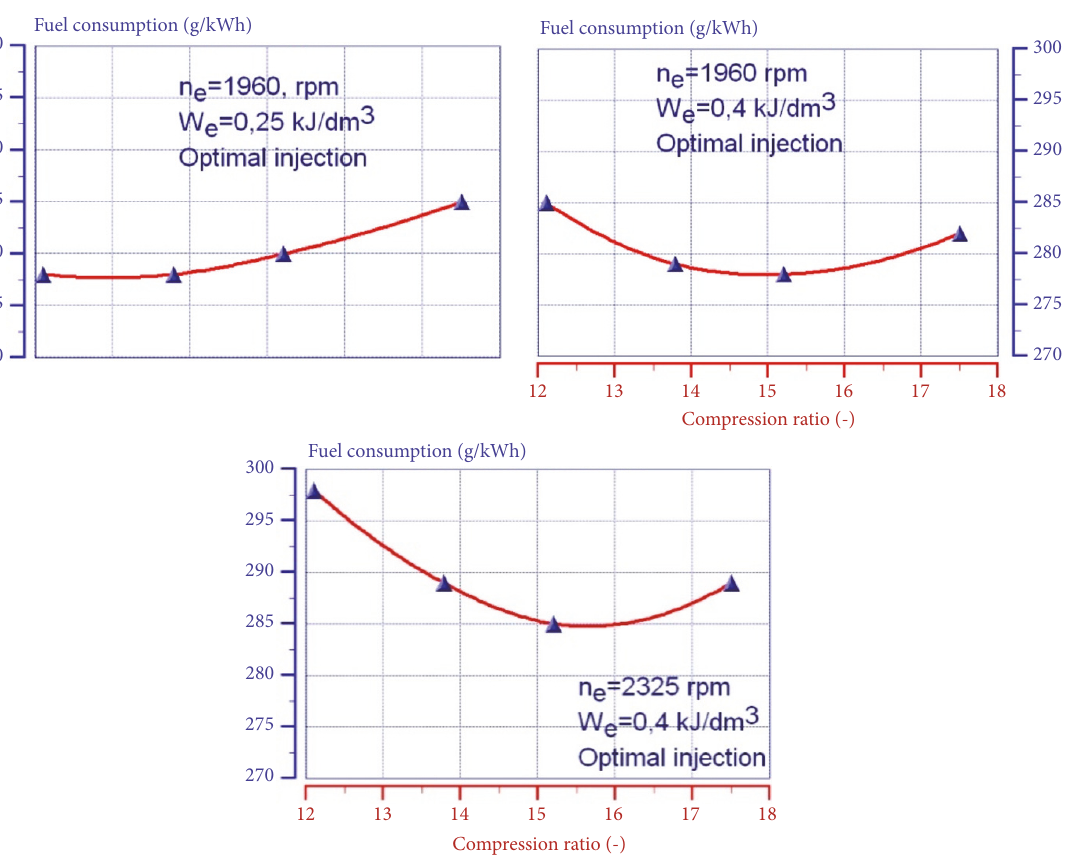
Figure 8: Influence of the (CR) on specific fuel consumption.